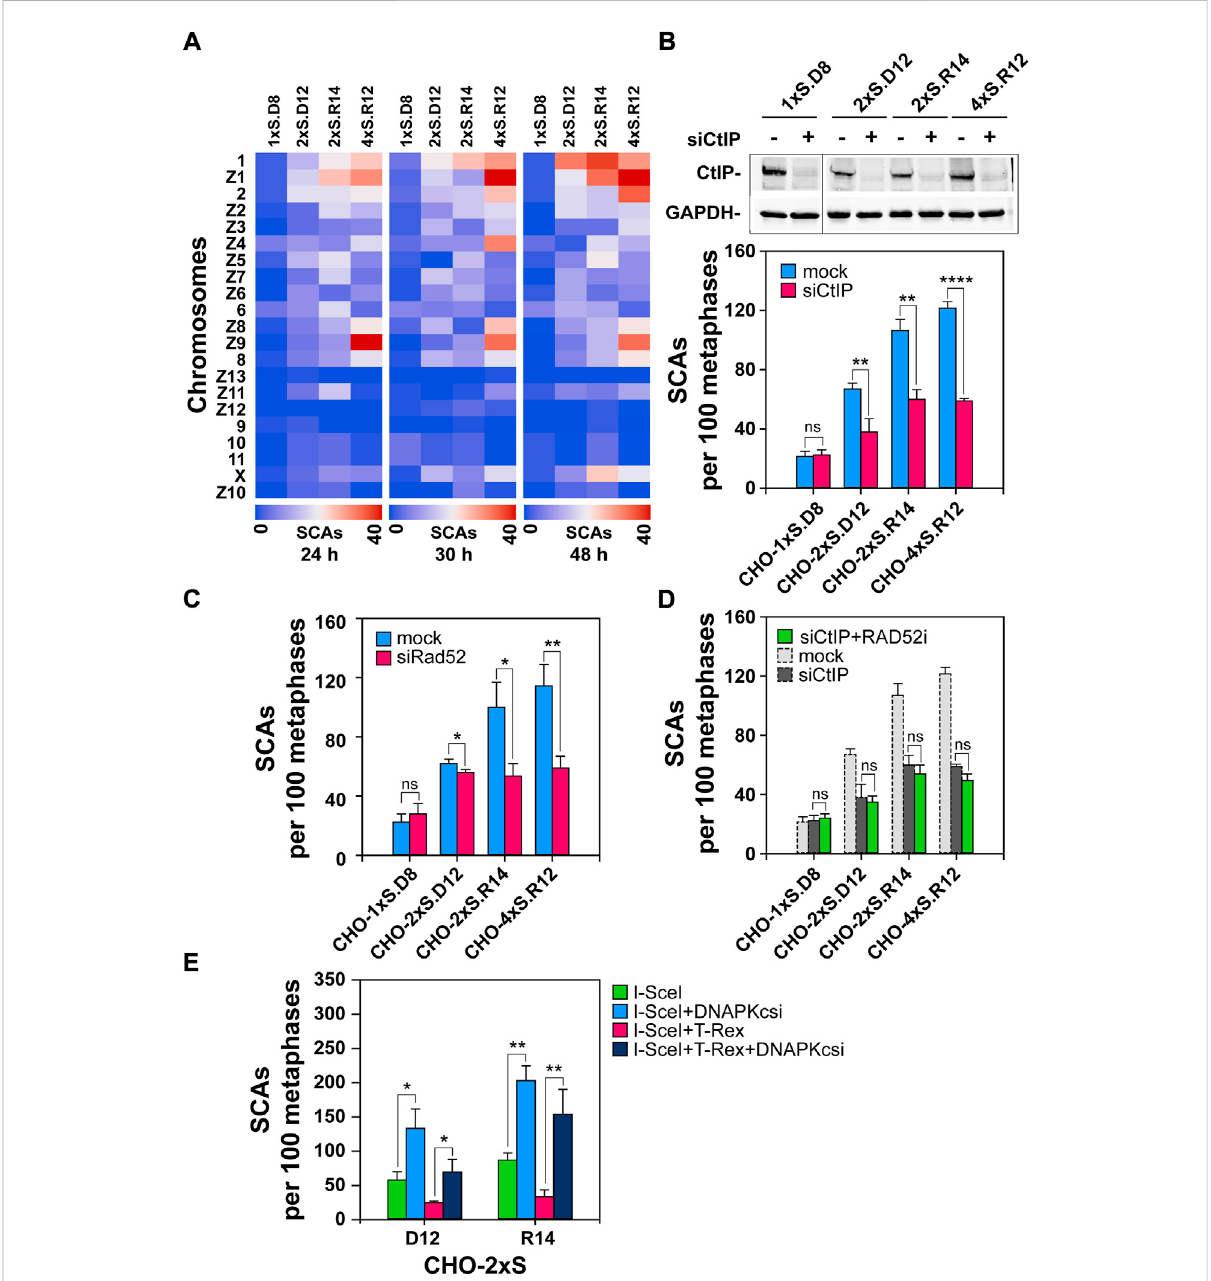
FIGURE 6 Depletion of CtIP or RAD52 and blunting of DNA-ends reduces SCAs in cells harboring DSB-clusters (A) Heat-map plots generated on the Orange software platform showing SCAs-frequencies of individual hamster chromosomes in the indicated clones. (B) Upper Panel: Western-blot analysis showing CtIP knock-down in the indicated clones; Lower Panel: QA of SCAs scored 24 h post-I-SceI transfection following CtIP depletion. (C) As in Figure 6B, Lower Panel, but for RAD52-depleted cells (D) QA of SCAs scored 24 h post I- Sce I transfection following CtIP depletion, combined with RAD52 inhibition. RAD52i was administered immediately after transfection and was kept for 24 h. Results represent means and SD from at least three independent experiments; only two independent experiments are conducted for CtIP-depletion in combination with RAD52 inhibition. (E) SCAsscored24 hpost transfection witheither theI-SceI expressionvector alone,ortogetherwiththeTREX-expressionvector in CHO-2xS.D12 or CHO-2xS.R14 cells, in the presence or absence of DNA-PKcsi. At least 100 metaphases are scored per sample. Data represent means and standard deviations (±SD) from three independent experiments. (ns, no signi fi cance, p > 0.05); (* p ≤ 0.05); (** p ≤ 0.01); (*** p ≤ 0.001); (**** p ≤